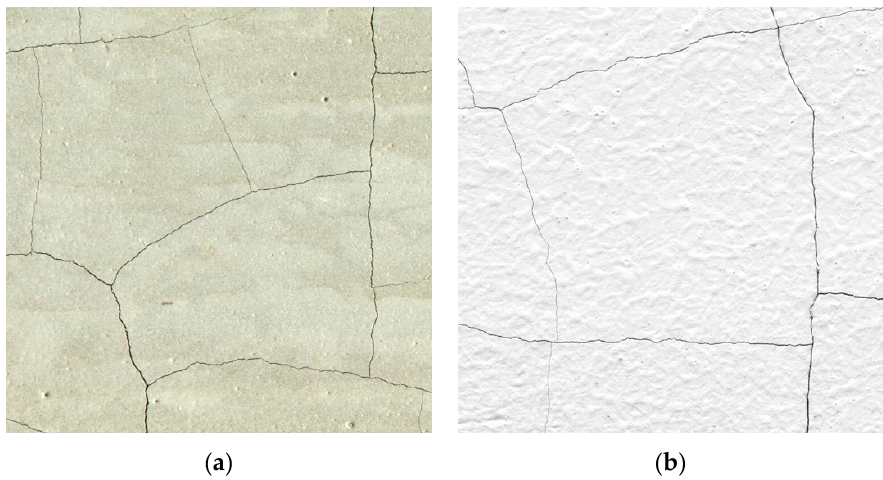
Figure 4. Scanned fragment of the cement paste surface: ( a ) before applying the acrylic film; ( b ) after applying the acrylic film.